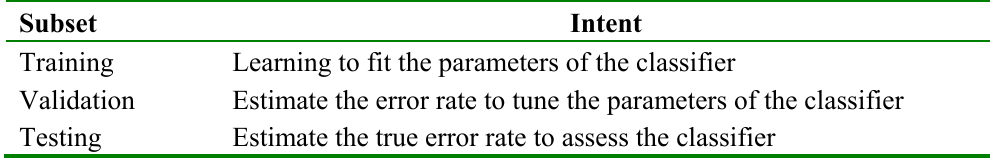
Table 4. Purposes of different